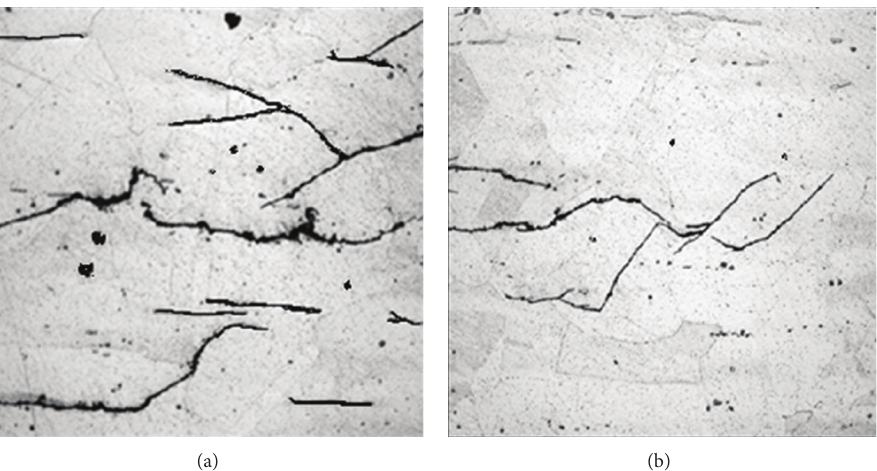
Figure 4: (a) Austenitic stainless steel type 304 (80 𝜇 m) showing a severe chloride stress corrosion cracking and several large pits. (b) Austenitic stainless steel type 316L (80 𝜇 m) showing a classical chloride stress corrosion cracking and small size pits.